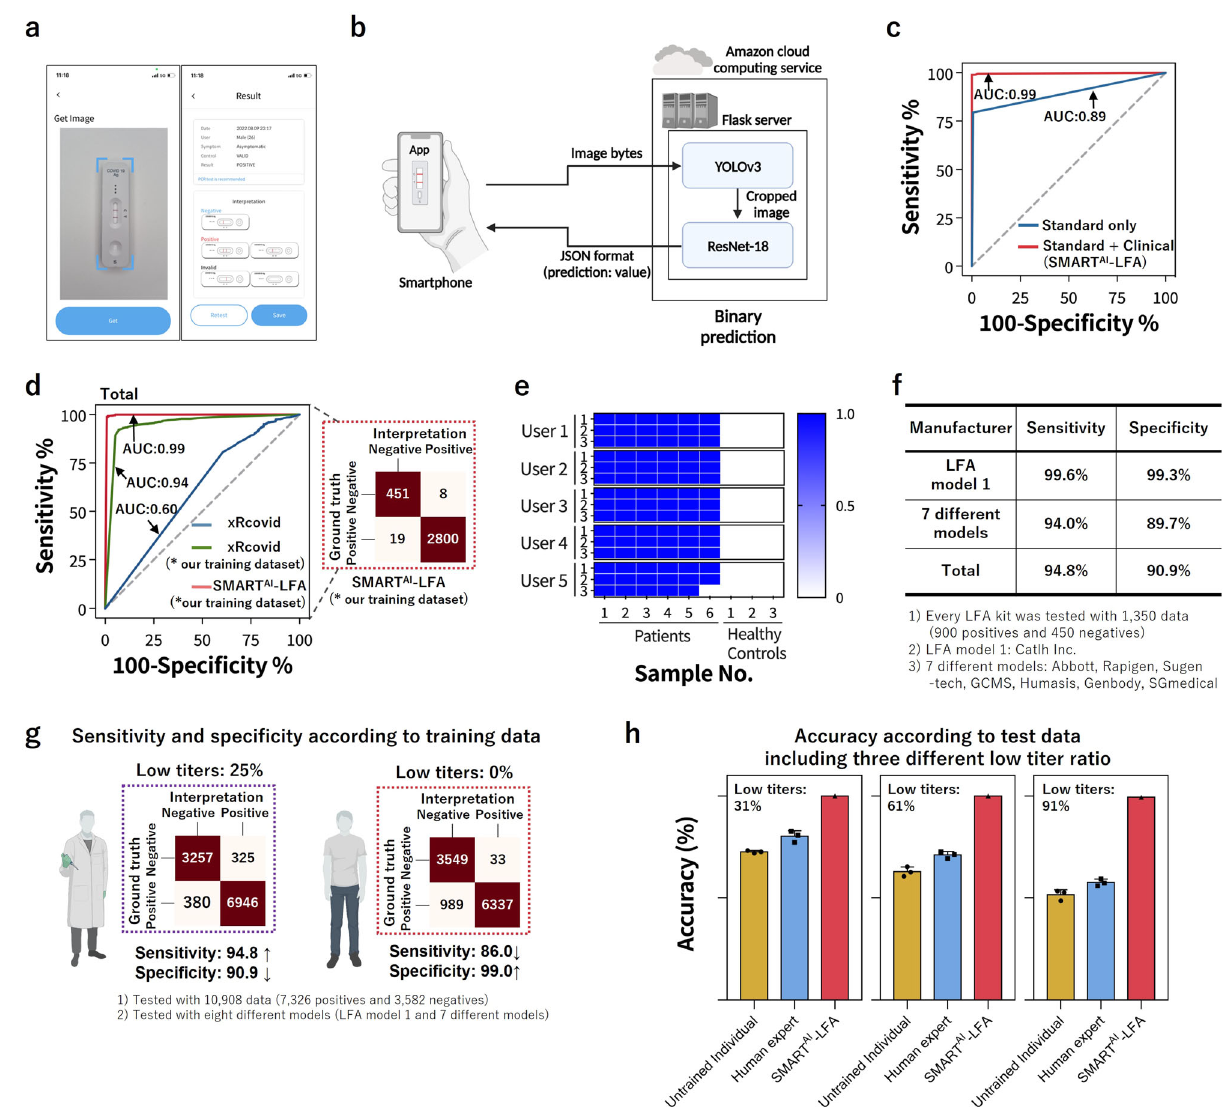
Fig. 4 | Clinical tests with a smartphone application. a Smartphone application and b schematicdiagramdepictingthedata fl owsfromasmartphonetotheserver (AWS), where the two algorithms are located. c The ROC curves according to training data (standard only ( n =8914) and additional clinical data ( n =8005)). d The ROC curves and confusion matrix of the two algorithms (SMART AI -LFA and xRcovid)forclinicaltests( n =3278). e , f Universalitytest. e Theaccuracy of the135 app-based tests with different users/smartphones, showing 98% accuracy. f The total averaged sensitivity and speci fi city from eight different LFA models (LFA